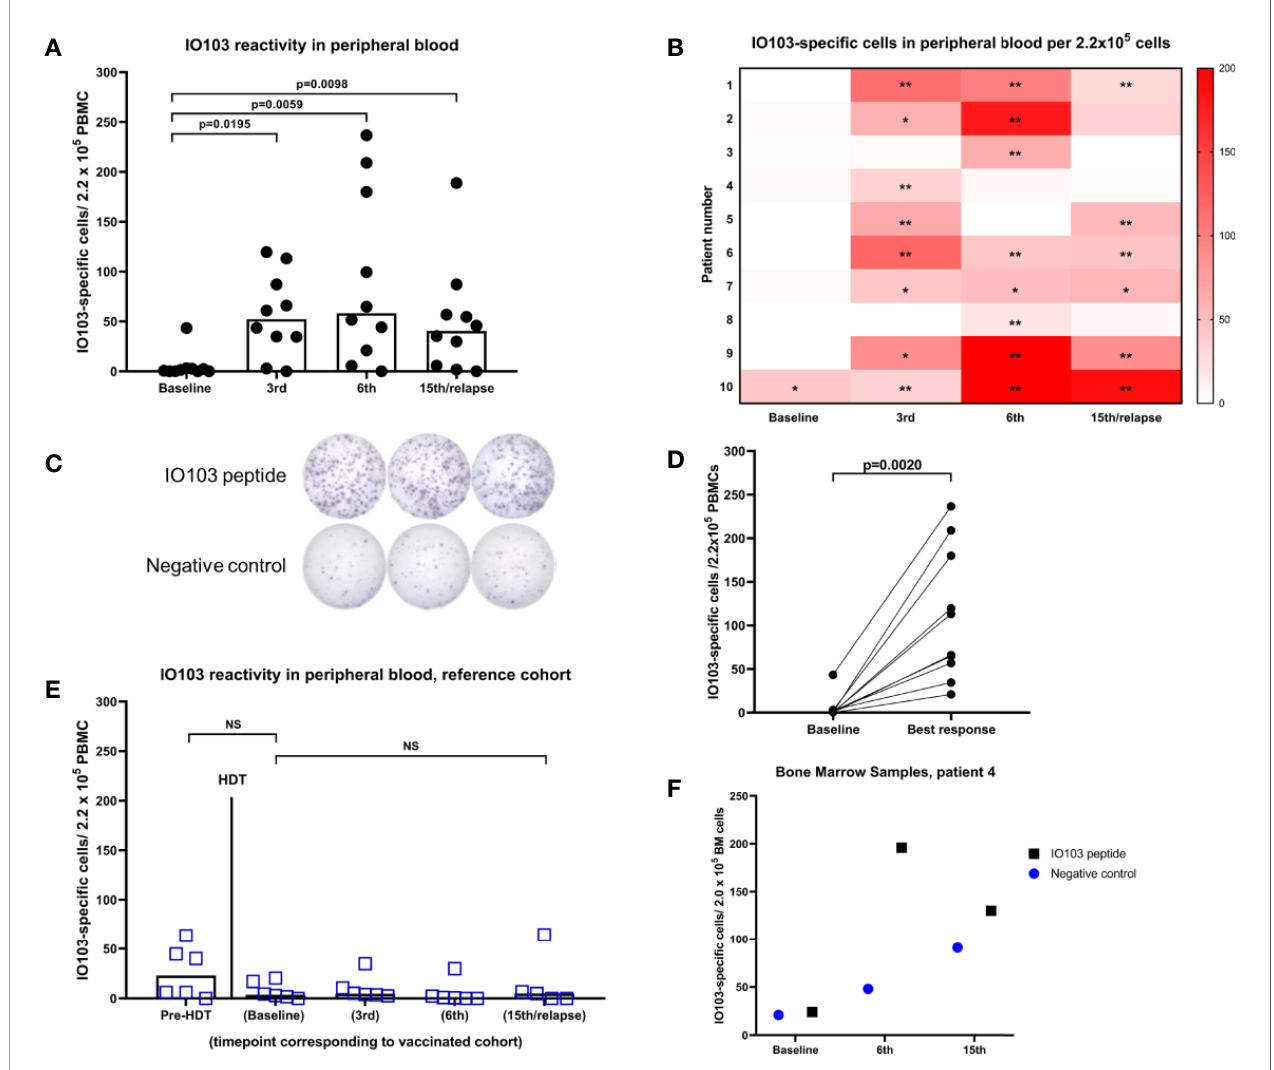
FIGURE 1 | IFN g -ELISPOT immune responses against IO103. (A) responses in PBMCs in vaccinated patients (bars represent median); (B) Heatmap of responses in PBMCs per vaccinated per time point. (*DFRx1; **DFRx2); (C) representative example of ELISPOT-wells with response; (D) best response in PBMCs in vaccinated patients; (E) responses in unvaccinated reference cohort including time point before HDT (All p-values: Wilcoxon matched-pairs signed rank test); (F) IFN g -ELISPOT responses against IO103 in bone marrow samples from patient